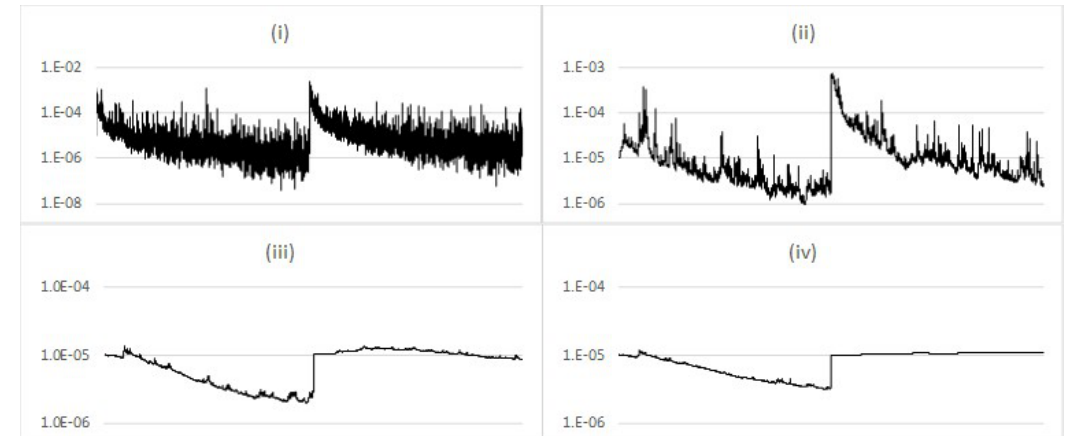
Figure 12. Comparison of average φ (log-scale) for the regime change model with different values of filter perturbation variance parameter γ ( i ) 1.0; ( ii ) 0.01; ( iii ) 0.001; ( iv ) 0.0001.